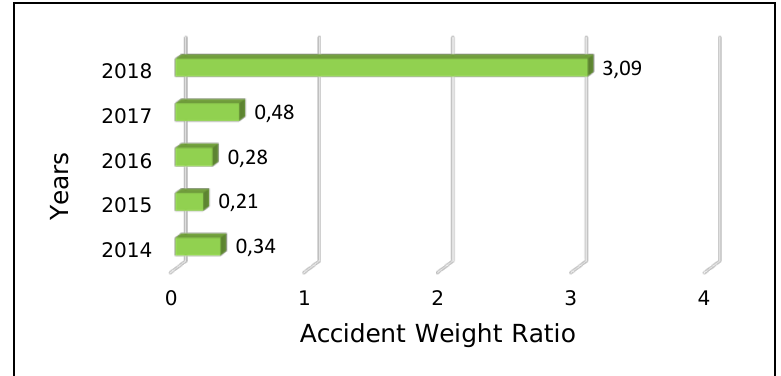
Figure 5. Accident Weight Ratio for the Years 2014 and 2018